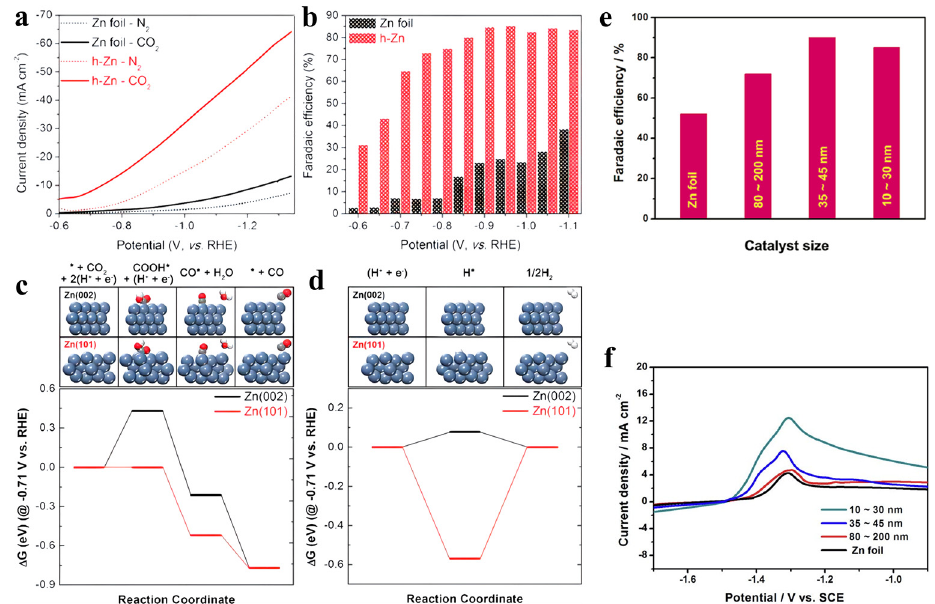
Figure 4. ( a ) LSV results in a N 2 (dotted line) or CO 2 -saturated (solid line) 0.5 M KHCO 3 electrolyte with a 50 mVs − 1 scan rate. ( b ) FE of CO at various constant potentials ranging from − 0.6 to − 1.1 V. ( c ) Free-energy diagrams for CO 2 reduction and ( d ) free-energy diagrams for HER on Zn (002) (black solid line) or Zn (101) (red solid line) At − 0.71 V. Atomistic structures optimized for each step are shown on the top. Navy blue, gray, red, and white colors represent Zn, C, O, and H atoms, respectively [50]. Reproduced form Ref. [50] with permission. © 2023 WILEY-VCH Verlag GmbH & Co. KGaA, Weinheim. ( e ) Dependence of FE CO on the zinc catalyst size. ( f ) LSV scans (from − 1.7 to − 0.9 V) in Ar-saturated 0.1 M NaOH for Zn catalysts with different particle sizes [53]. Reproduced form Ref. [53] with permission from the Royal Society of Chemistry.